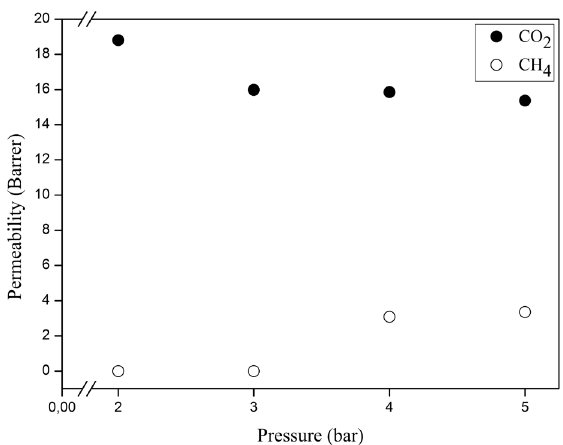
Figure 2 - Membrane permeability as a function of pressure at